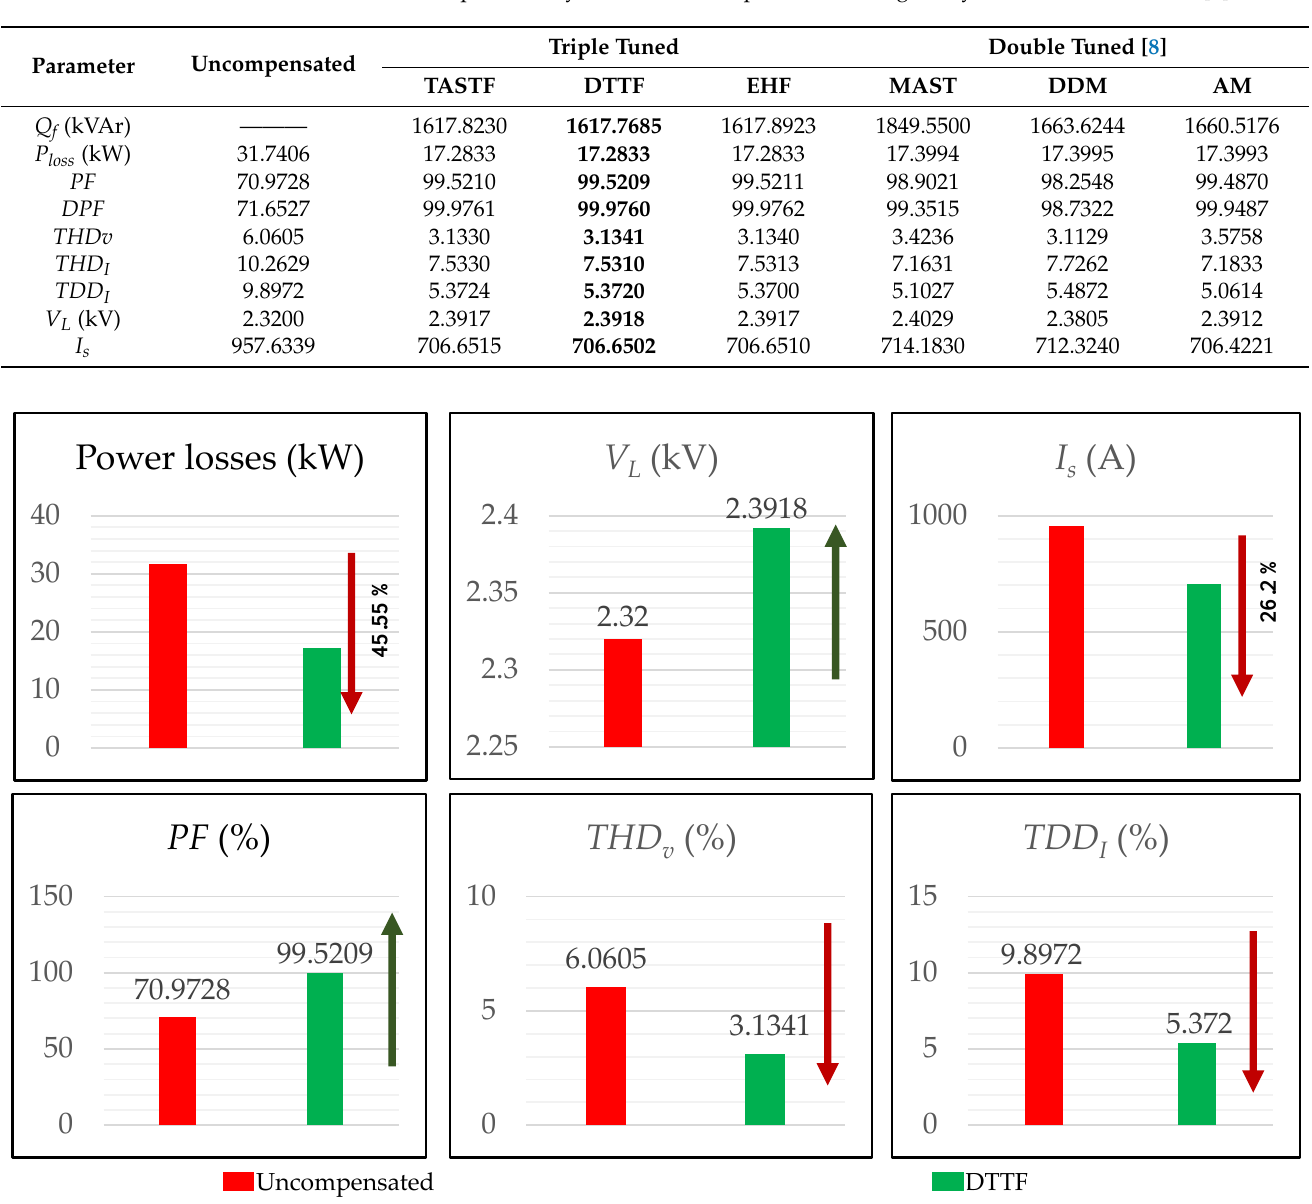
Figure 9. Performance of the DTTF in terms of the investigated metrics. Figures 10 and 11 show the individual harmonic distortion of load voltage ( IHD V ) and source current ( IHD I ) and their maximum values reported in IEEE Std. 519 [18]. Figure